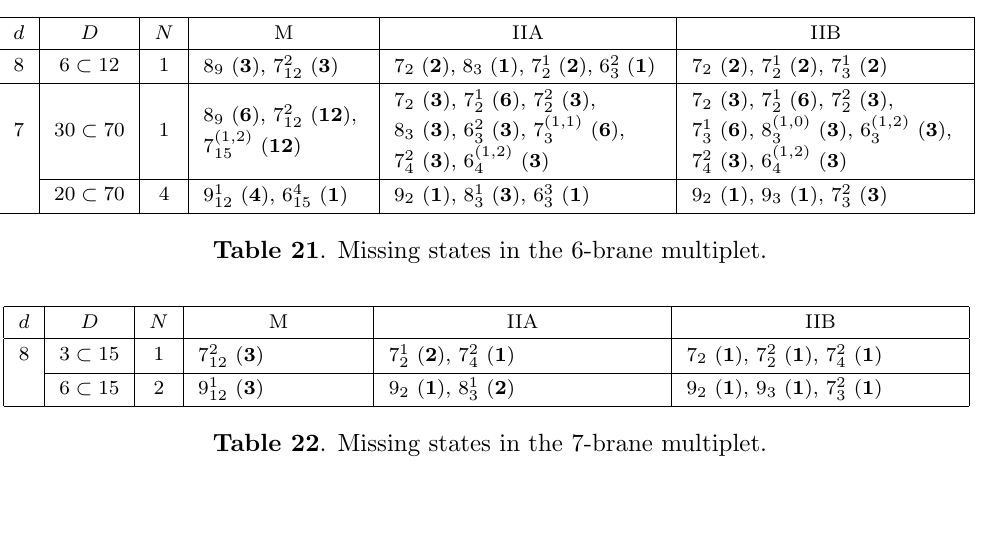
Table 20 . Missing states in the 5-brane multiplet.